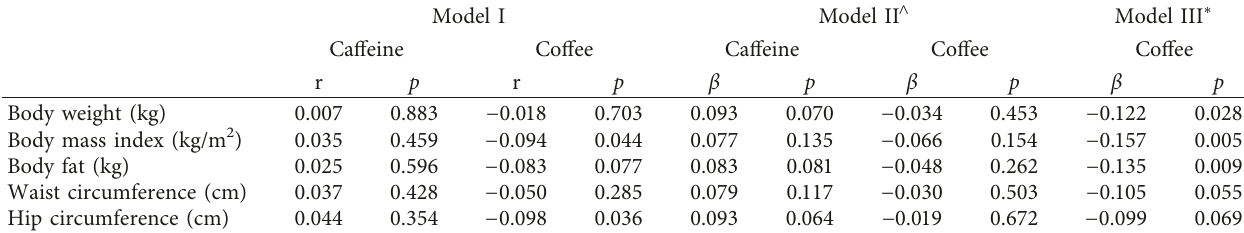
Table 2: The correlation between caffeine, coffee consumption, and adiposity.